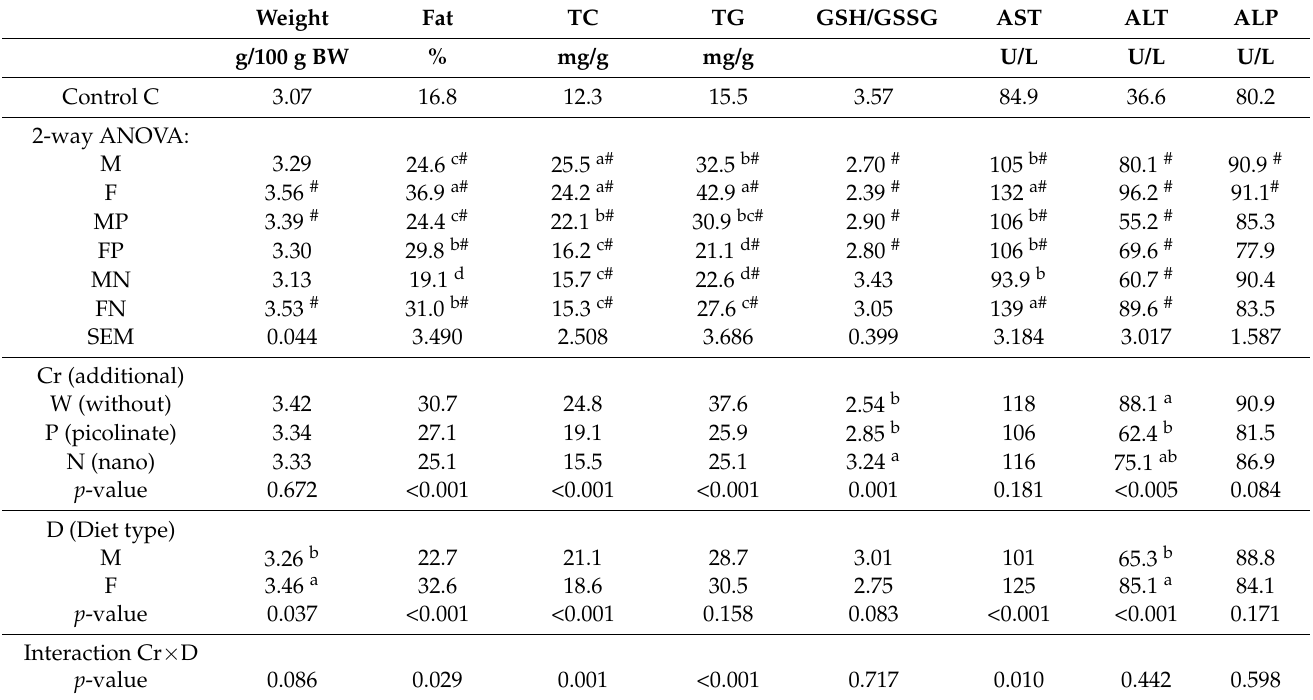
Table 2. Hepatic functional parameters and blood plasma AST, ALT and ALP activity in rats fed experimental diets ( n = 12 per group)